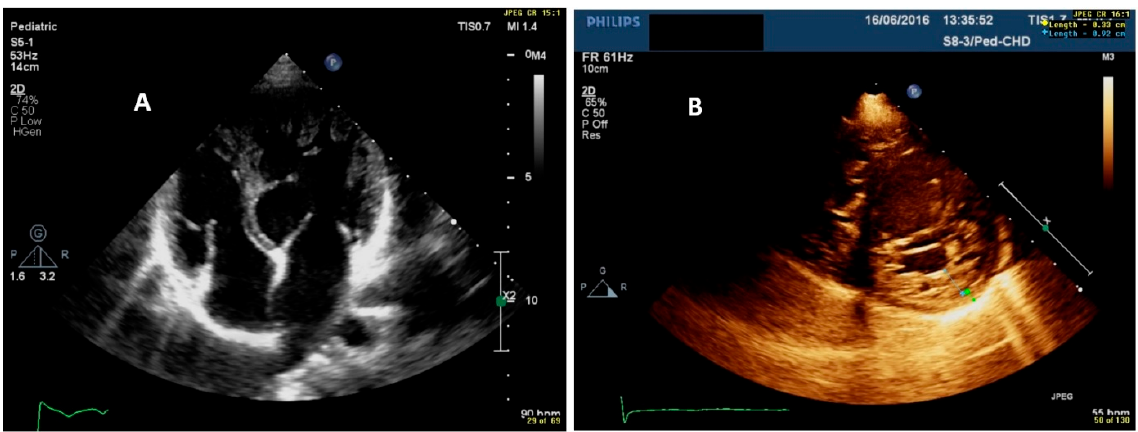
Figure 2. The 2D transthoracic echocardiography in a patient with LVNC. ( A ) Apical four-chamber projection: left ventricular noncompaction with deep recesses. ( B ) Parasternal short axis projection: the ratio of the left ventricular noncompacted to compacted layer(3:1).